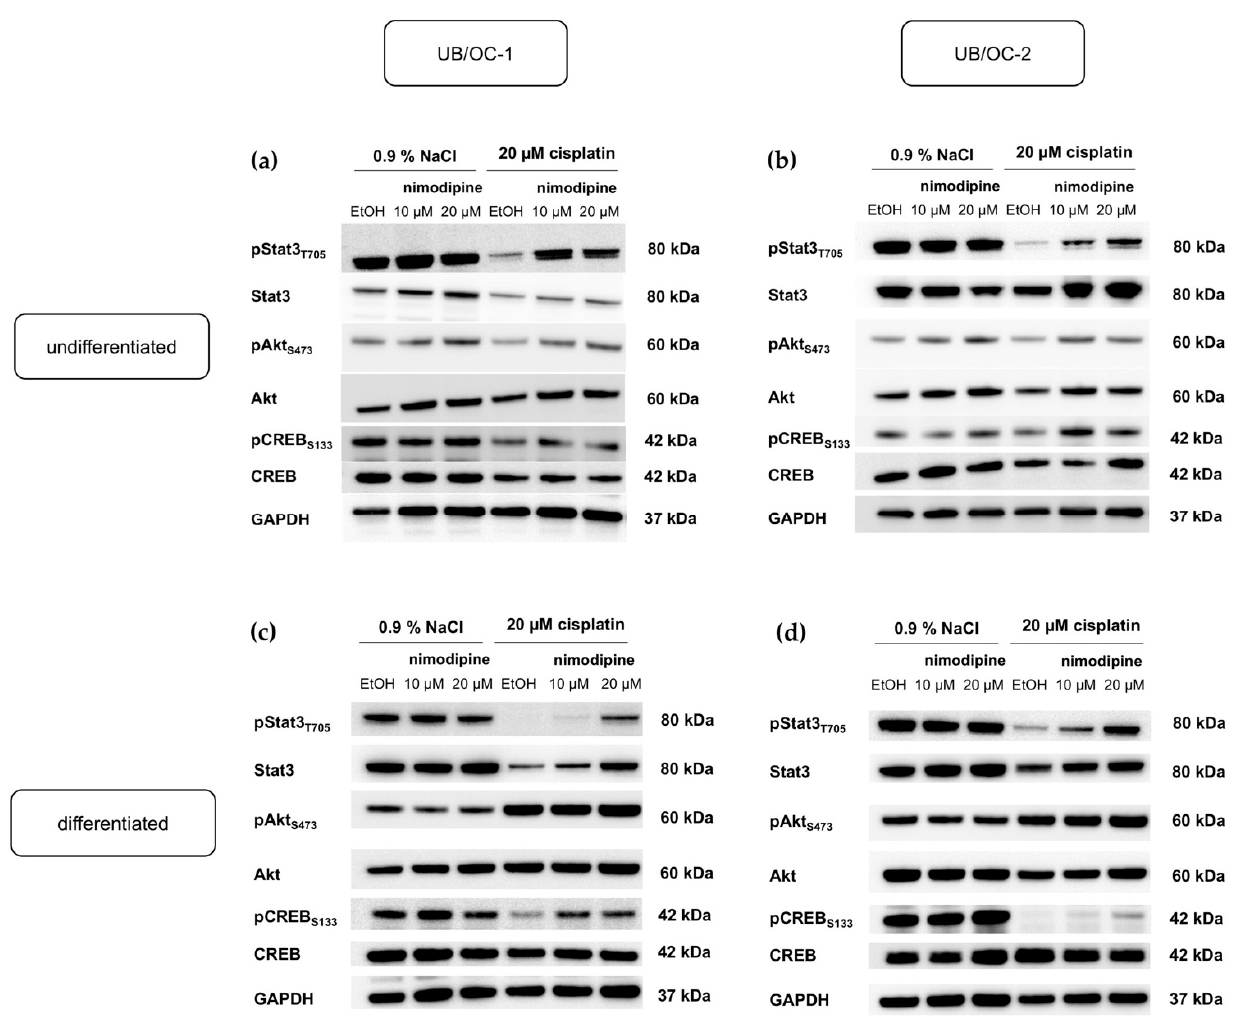
Figure 5. Detection of anti-apoptotic pathways activated by nimodipine during cisplatin treat- ment for undifferentiated UB/OC − 1 (a) and UB/OC − 2 (b) cells as well as for differentiated UB/OC − 1 (c) and UB/OC − 2 (d) cells. After transfer of the proteins separated by SDS-PAGE (30 µg) onto 0.45 µm nitrocellulose membranes, the phosphorylation and total protein amount of anti-apop- totic cell signaling components were determined by specific antibodies. As a loading control, GAPDH protein level was used. The Western blot shown is representative of the results from three independent biological replicates.